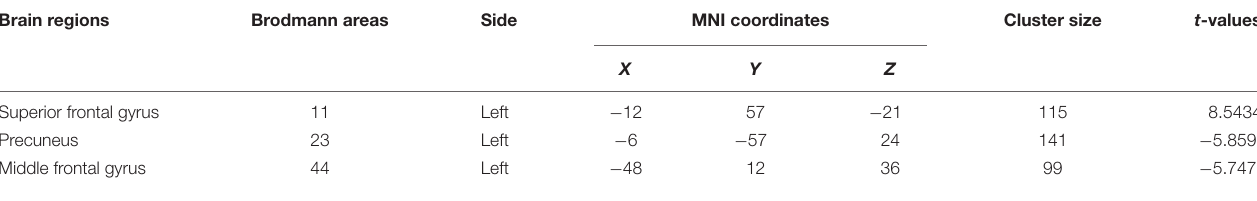
TABLE 4 | Brain regions in ALFF between post- and pre-rTMS. Brain regions